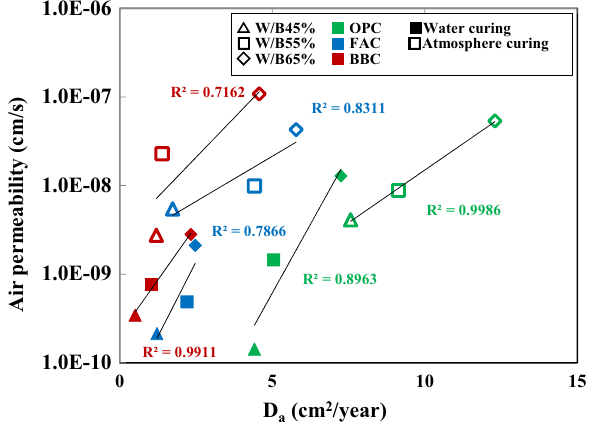
Fig. 8 Air permeability versus effective chloride diffusion coefficient by electrophoretic